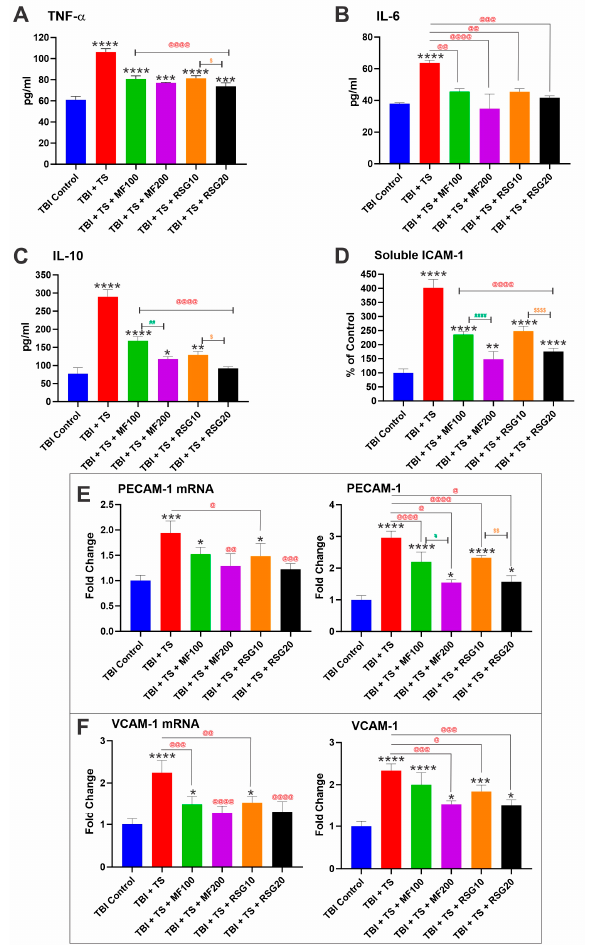
Figure 5. MF and RSG decrease inflammatory responses induced by premorbid TS exposure and TBI induction. ELISA results of pro-inflammatory cytokines ( A ) TNF- α , ( B ) IL-6, ( C ) IL-10, and ( D ) soluble ICAM-1 7 days after TBI. Protein expression and mRNA levels of the inflammatory adhesion molecules ( E ) PECAM-1 and ( F ) VCAM-1 were upregulated by TS exposure and TBI induction. n = 6 biological replicates, * p < 0.05, ** p < 0.01, *** p < 0.001, **** p < 0.0001 versus control. @ p < 0.05, @@ p < 0.01, @@@ p < 0.01, @@@@ p < 0.0001 non-treated versus MF/RSG-treated group. # p < 0.05, ## p < 0.01, #### p < 0.0001 MF100 versus MF200. $ p < 0.05, $$ p < 0.01, $$$$ p < 0.0001 RSG10 versus RSG20.